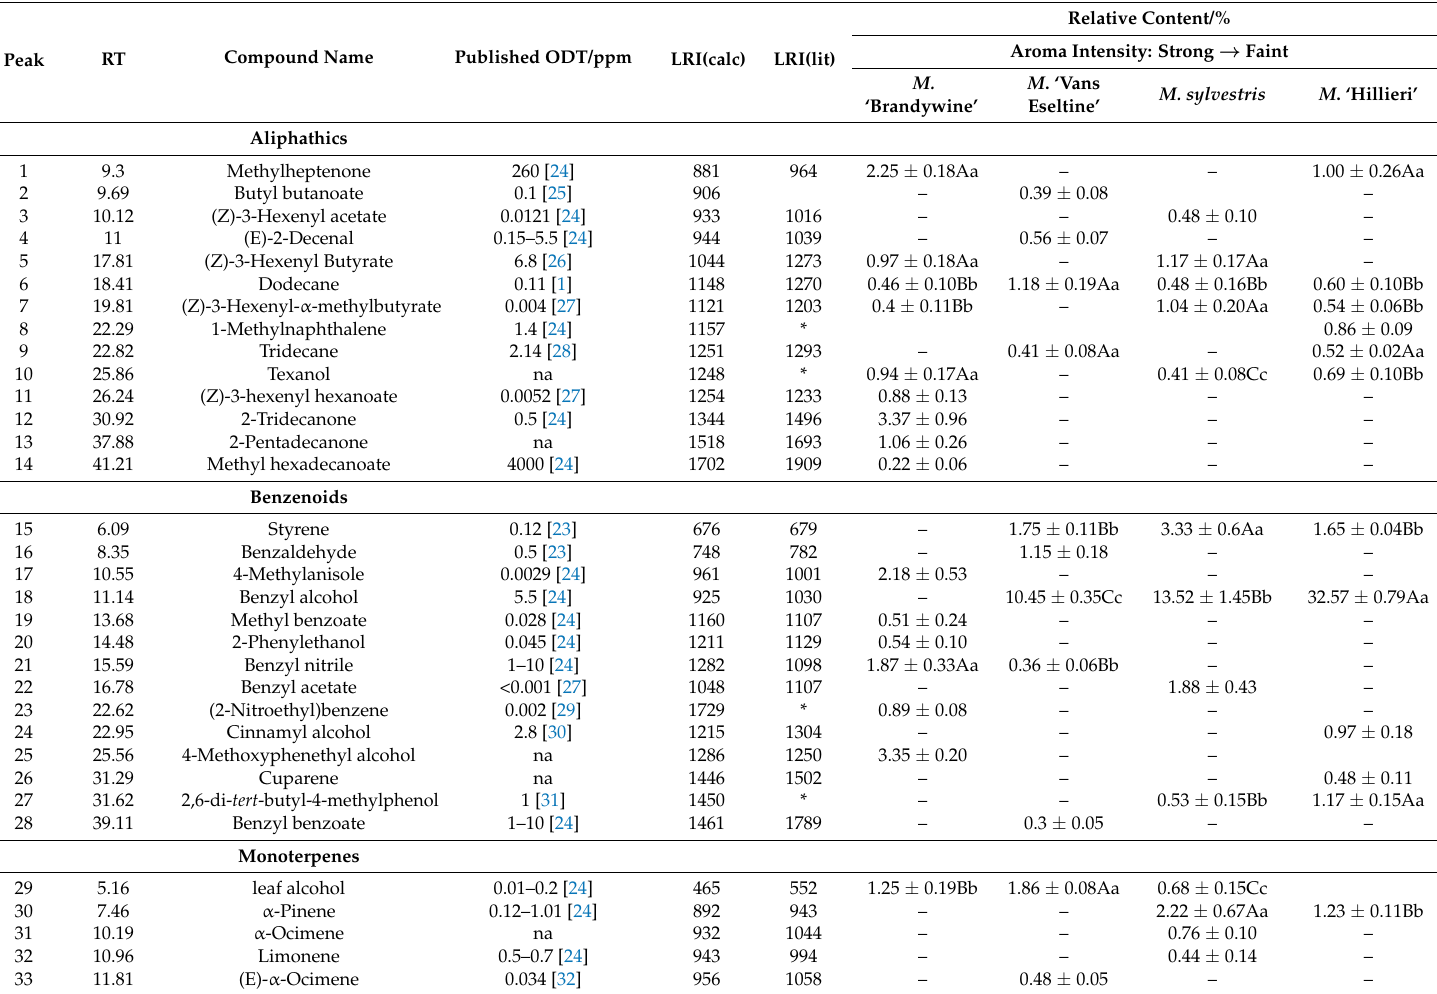
Table 2. Volatile compounds identified in the flowers of four Malus taxa using